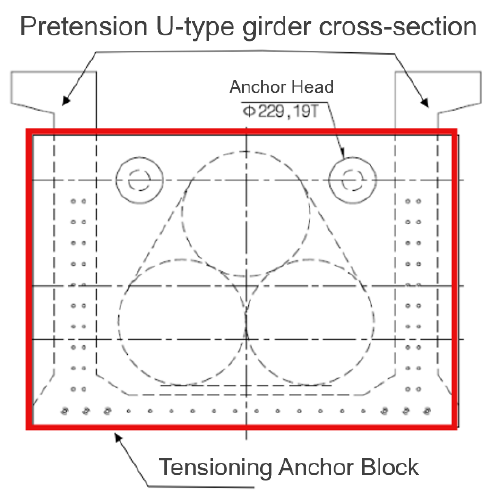
Figure 5. Cross section of pre-tension U-type girder and anchorage block for tension.